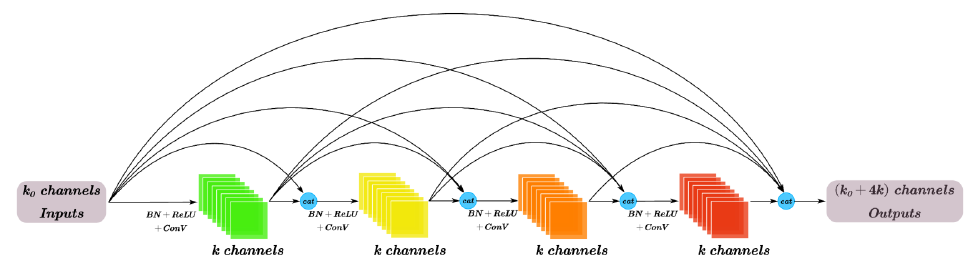
Figure 9. 4-layer dense block.